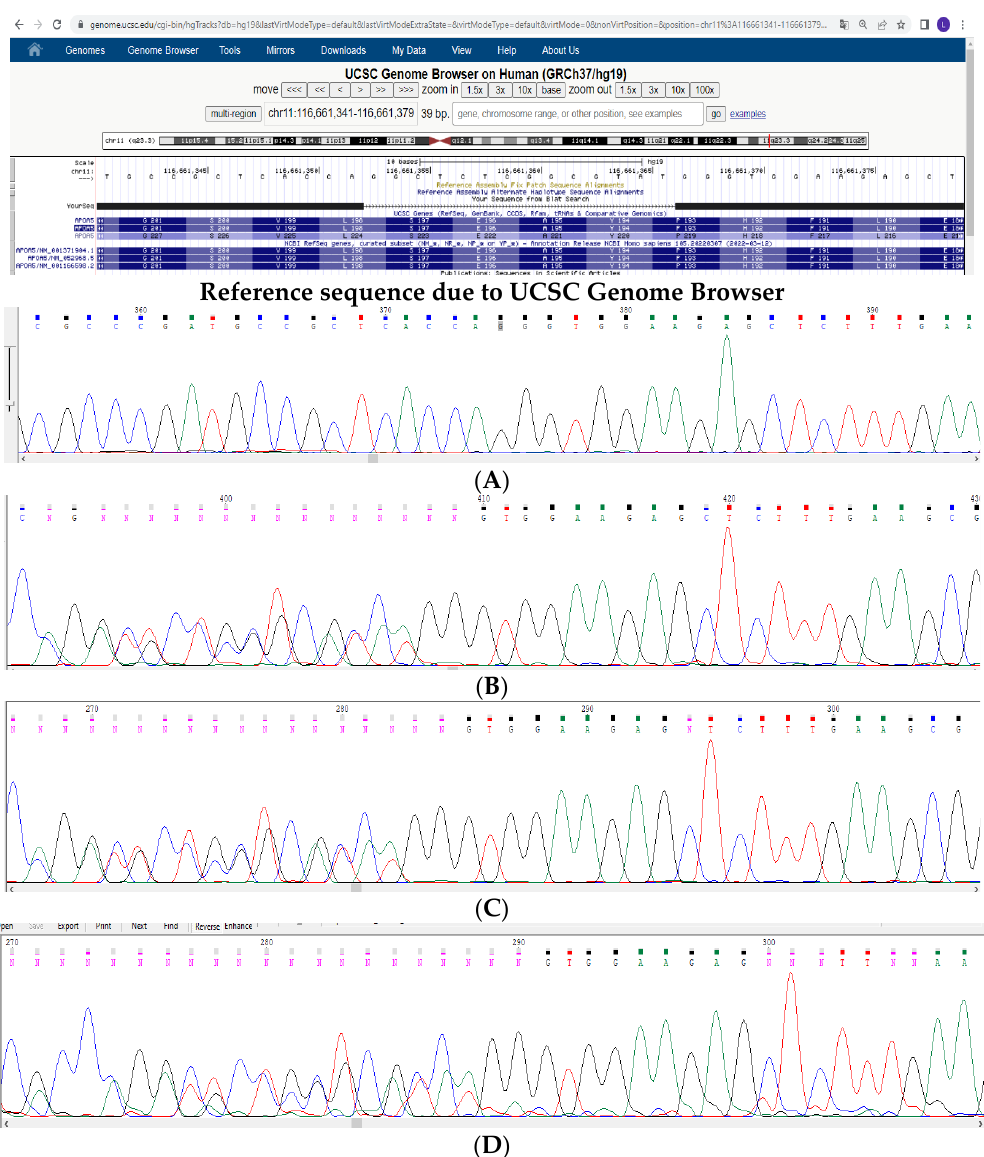
Figure 3. Reference sequence due to UCSC Genome Browser and Sanger sequencing electrograms of: ( A ) proband, ( B ) mother, ( C ) father, and ( D ) sibling (brother).